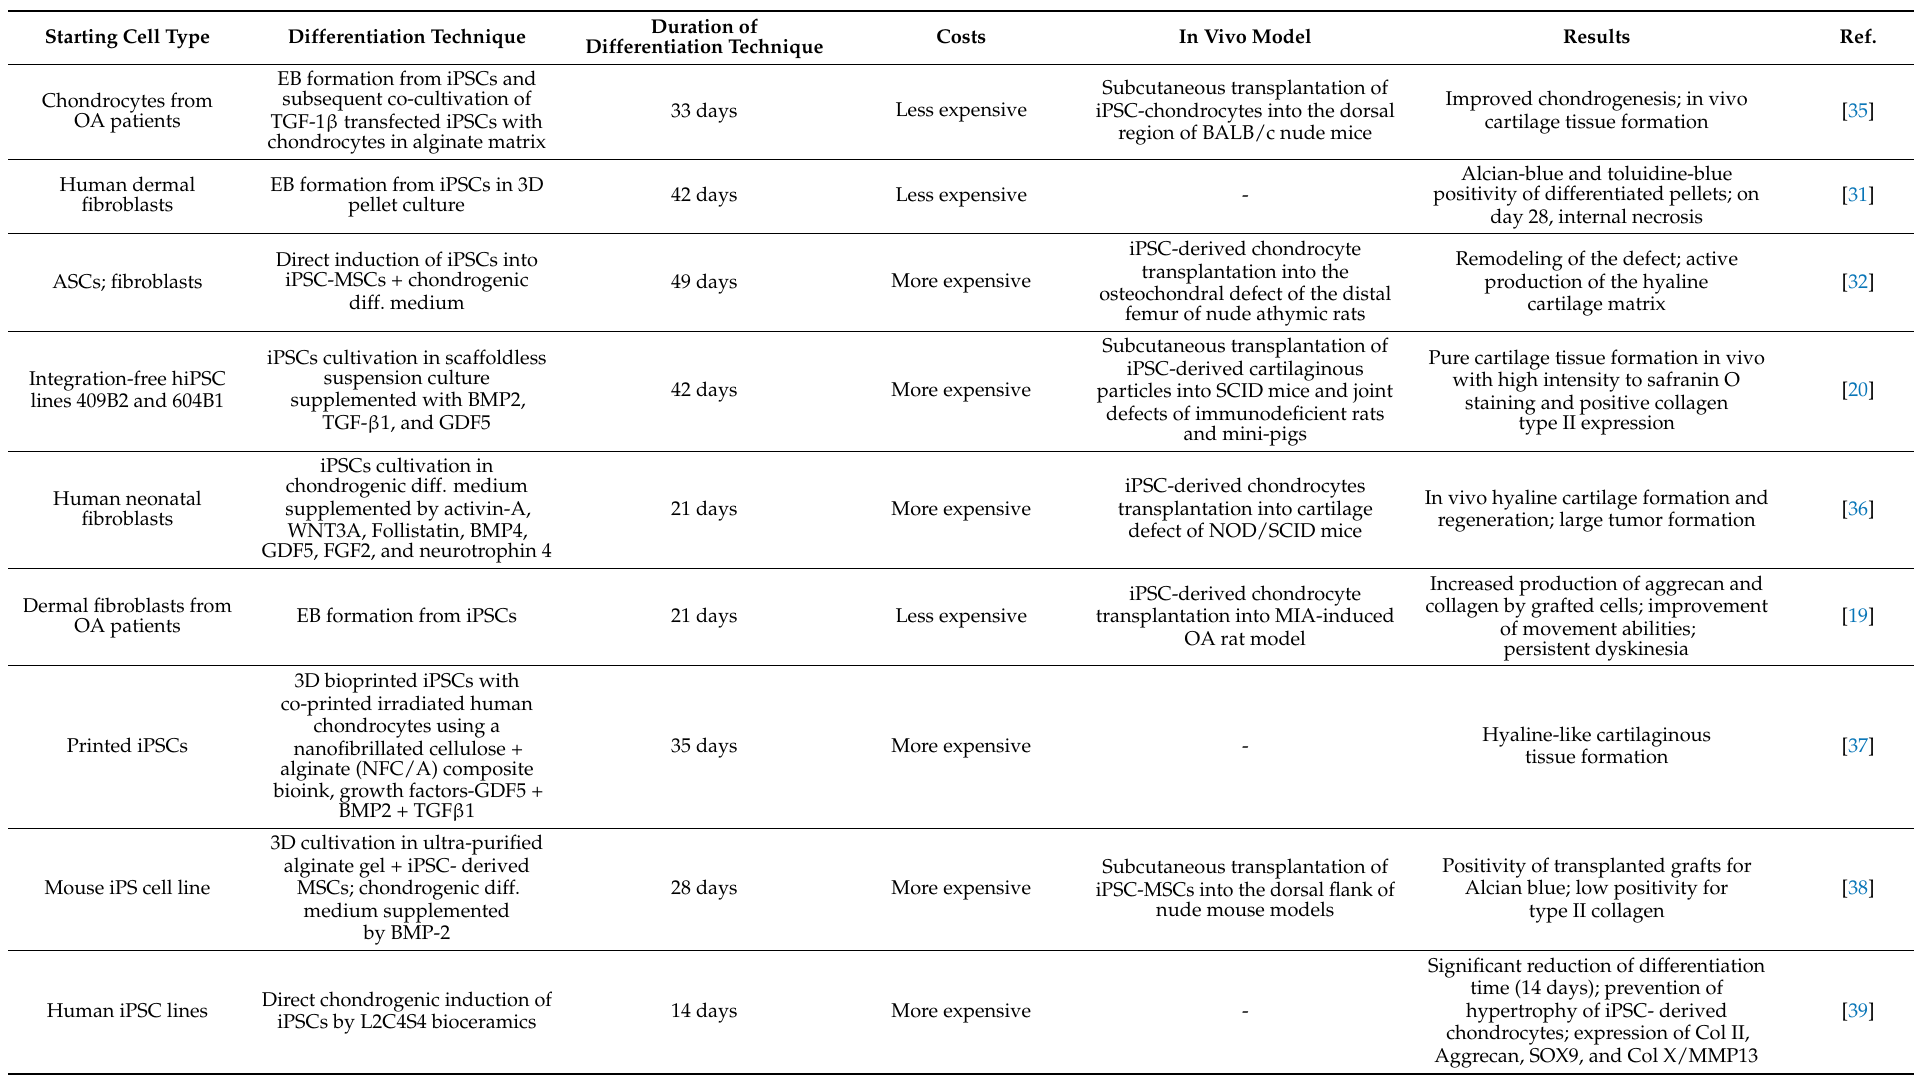
Table 2. Overview of different study design applying iPSCs in osteoarthritis (OA)